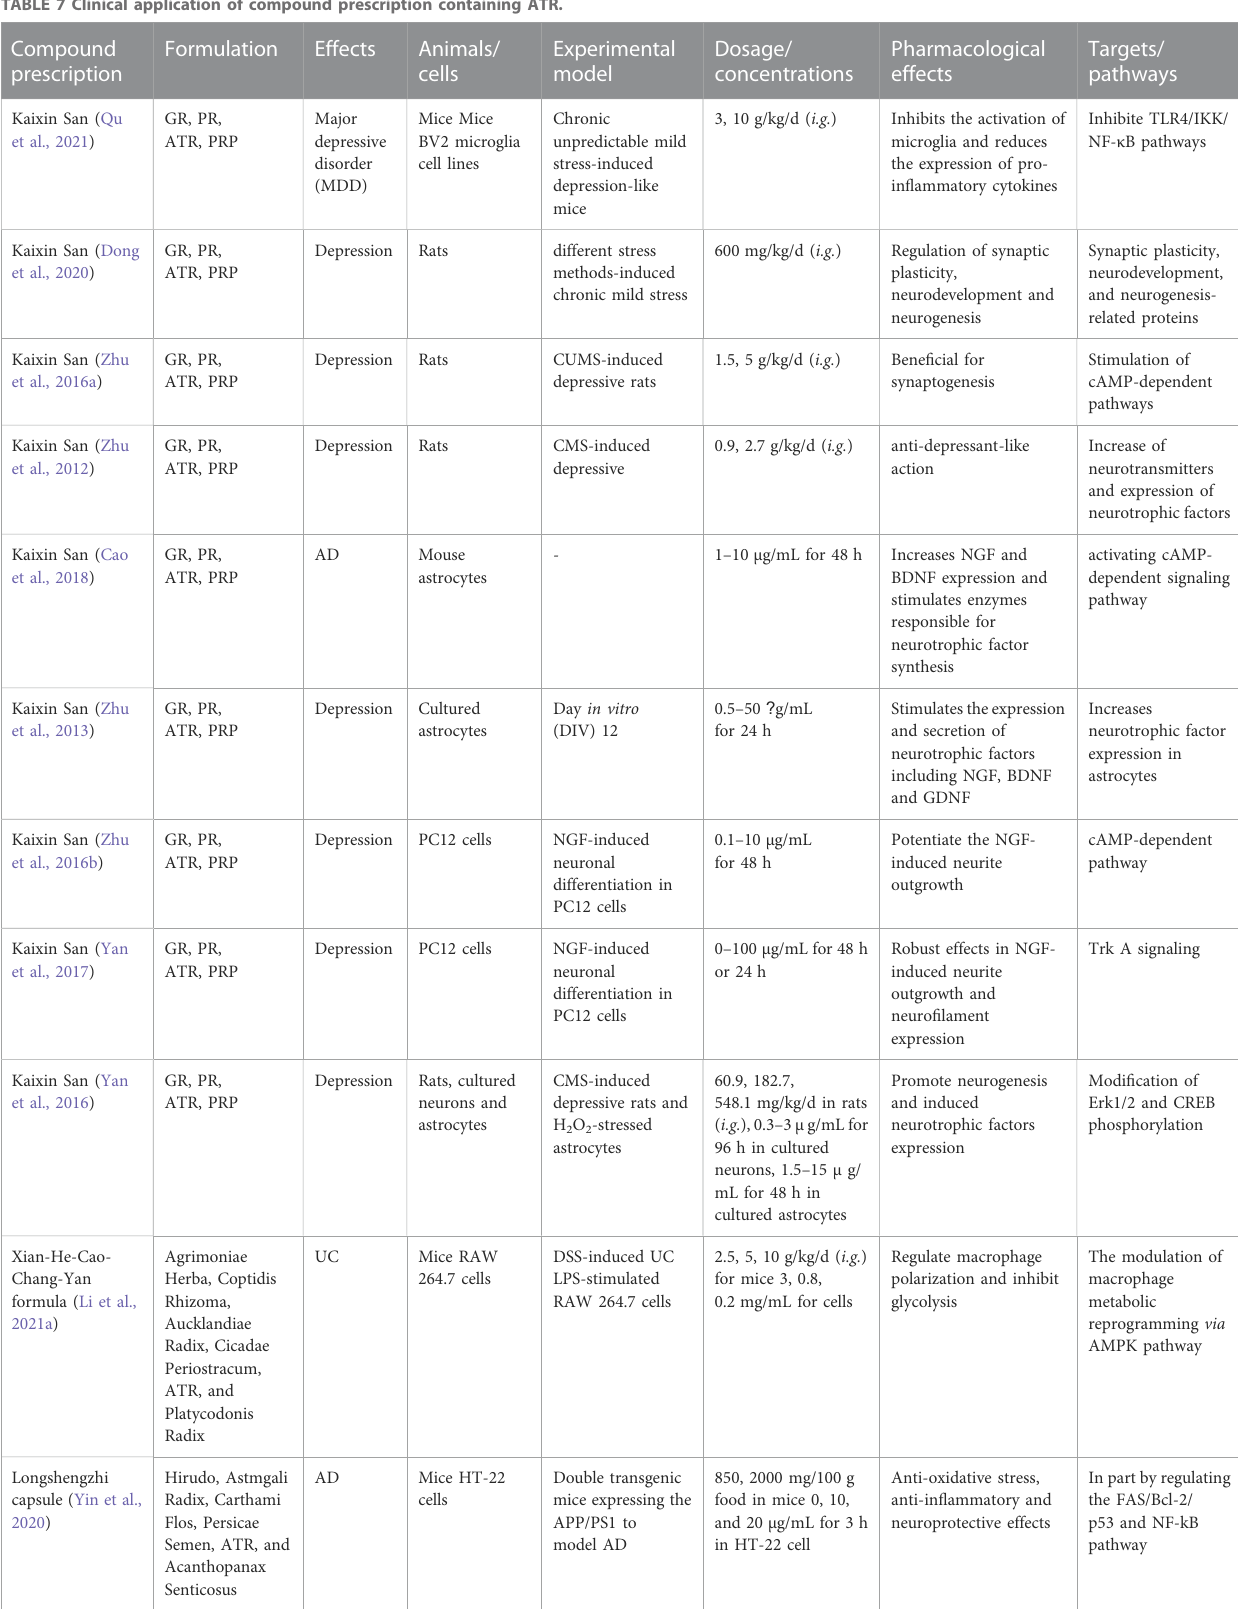
TABLE 7 Clinical application of compound prescription containing